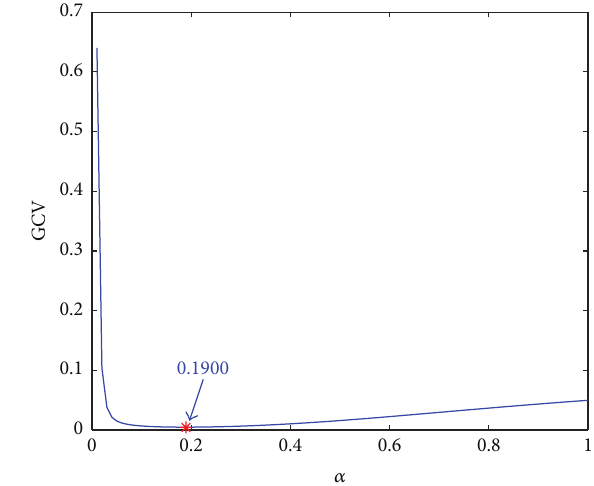
Figure 15: GCV for load identification of MIMO system.